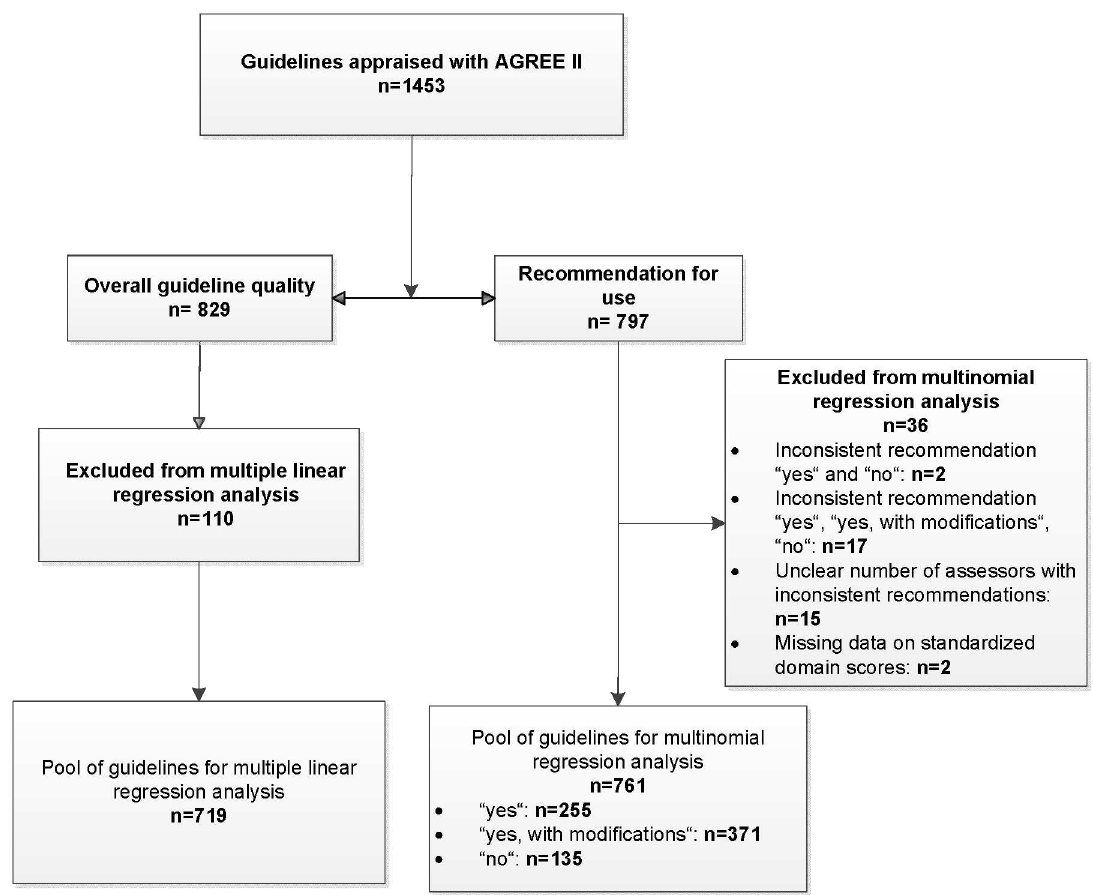
Fig 2. Guideline pool for the multiple linear and multinomial regression analyses.